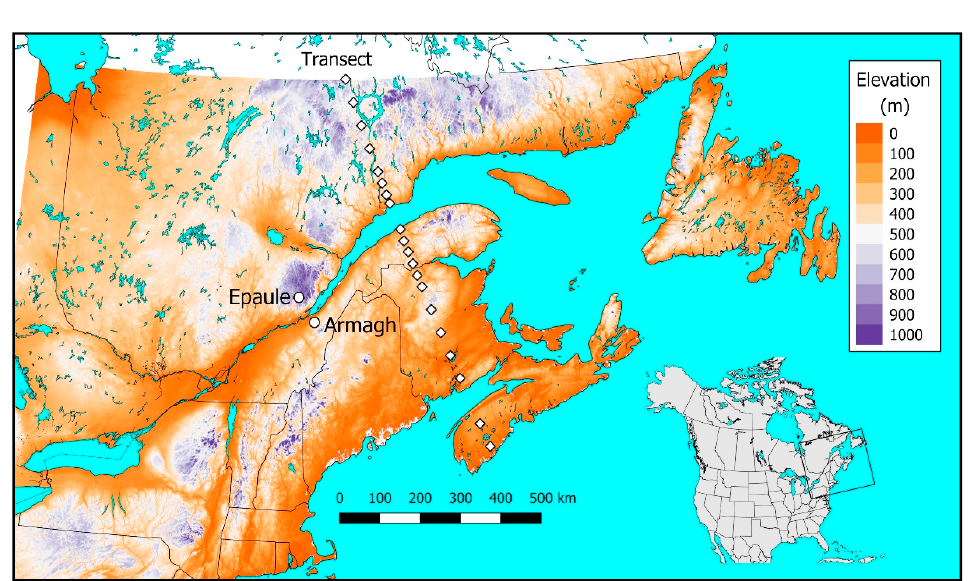
Figure 1. Elevation map of the portion of eastern North America considered in this study. Diamonds: Latitudinal transect locations. Circles: Armagh and Epaule locations.